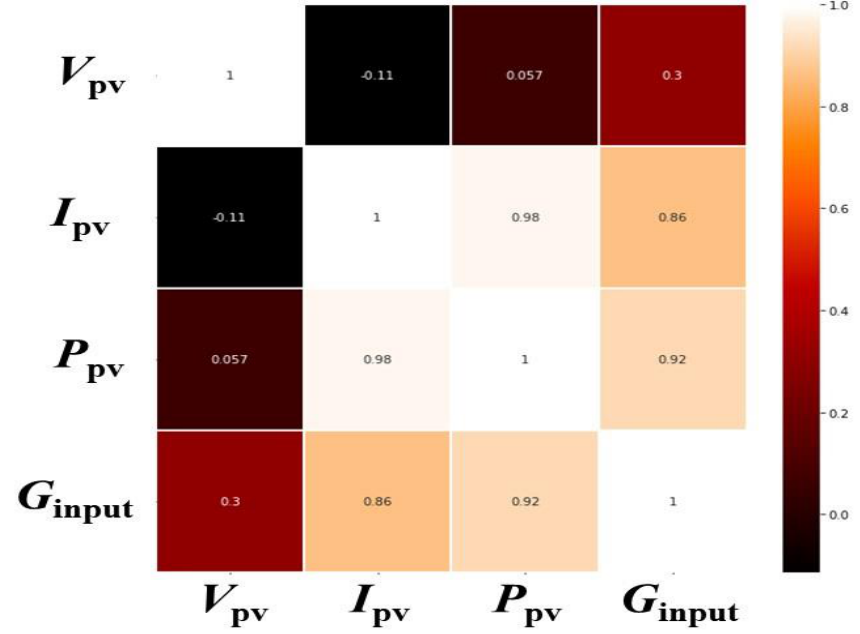
Figure 9. Comparison of the experimental and simulated data for the deep learning model.